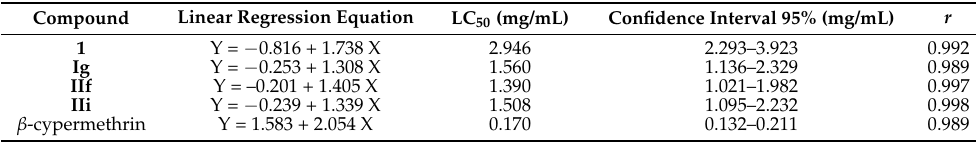
Table 3. LC 50 values at 48 h of compounds 1 , Ig , IIf , and IIi against P. xyllostella a . Compound Linear Regression